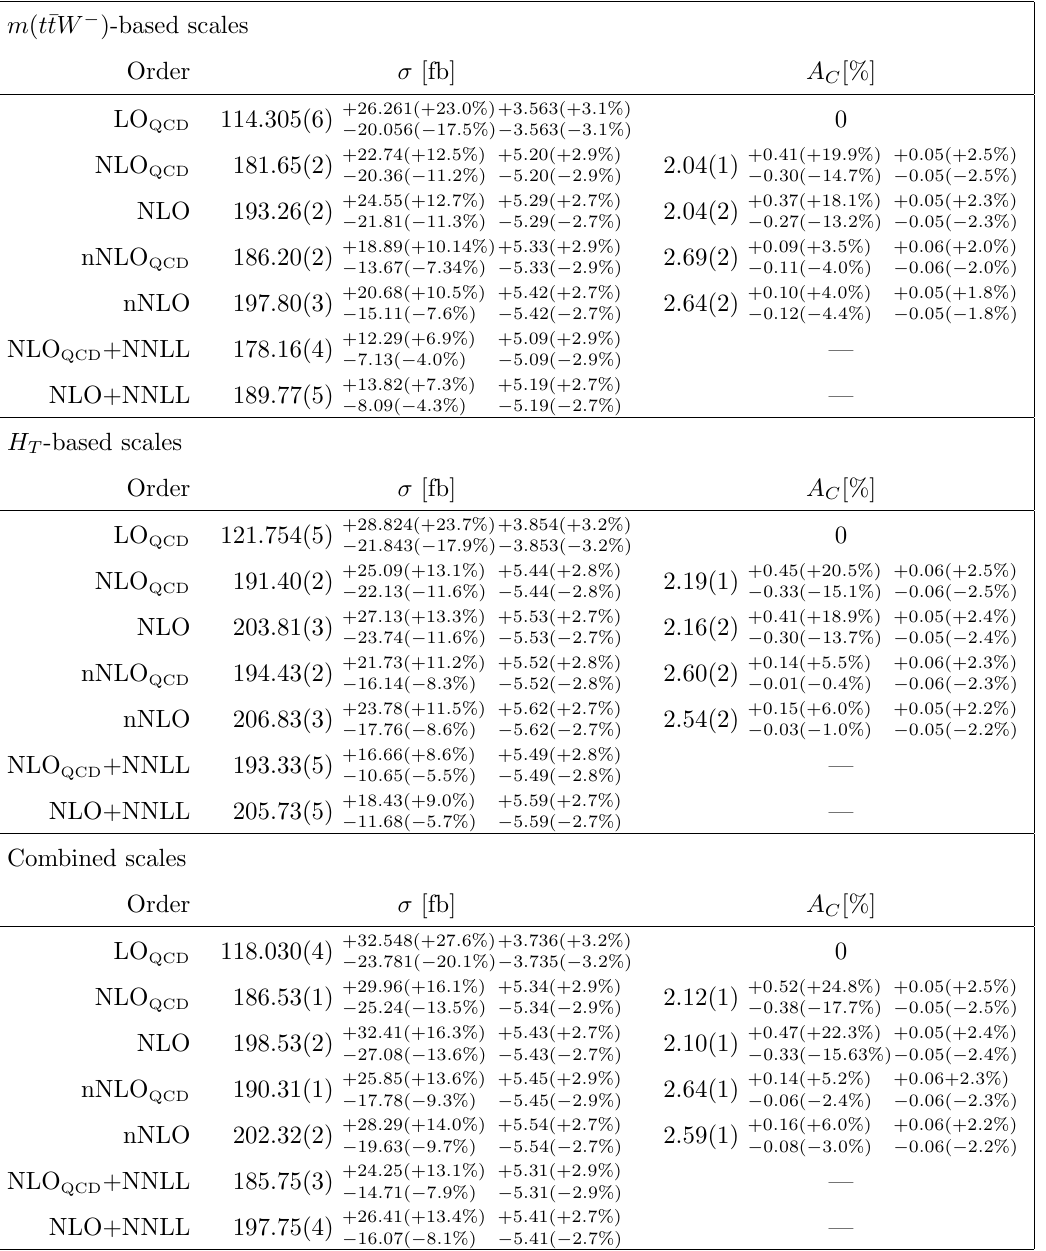
Table 2 . Total cross section and charge asymmetry for t (cid:22) tW (cid:0) production. Same structure as in table